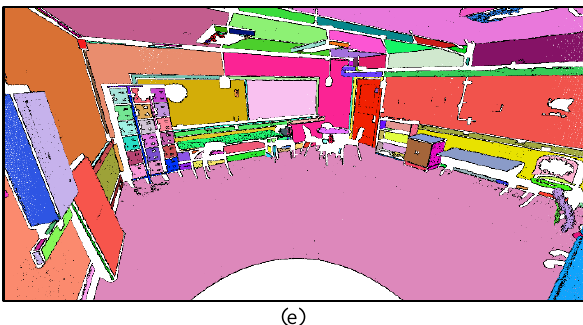
Figure 3. Segmentation results based on edge detection: (a) initial TLS data presented as an angular grid image colored by intensity; (b) the initial TLS data colored by image texture; (c) points lying on silhouettes (blue) are extracted; (d) points with large variation in normals are extracted as edges (orange); (e) grouping of smooth surfaces following region growing where the borders of each segment are colored in black and each segment is randomly colored.